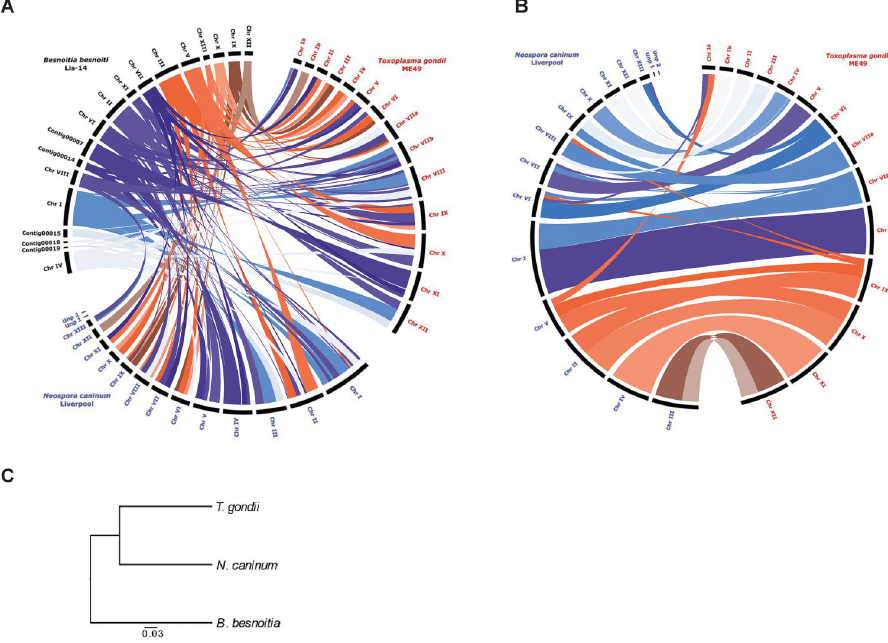
Fig 5. Synteny and orthology between Besnoitia besnoiti , Toxoplasma gondii and Neospora caninum . (A) Synteny mapping of the 19 contigs of B . besnoiti that are larger than 100 kb shows the genomic organization of the B . besnoiti genome to T . gondii and N . caninum . Syntenic regions are highlighted with coloured lines within the circle. Labelling of the B . besnoiti chromosomes is according to GenBank ( B . besnoiti Ger1 reference strain). (B) Synteny mapping as in (A), but exclusively of T . gondii and N . caninum contigs. (C) Phylogenetic organization of B . besnoiti , T . gondii and N . caninum . Branch length represents substitution rate (substitutions per site). Chr: Chromosome; Unp: Unplaced contig.